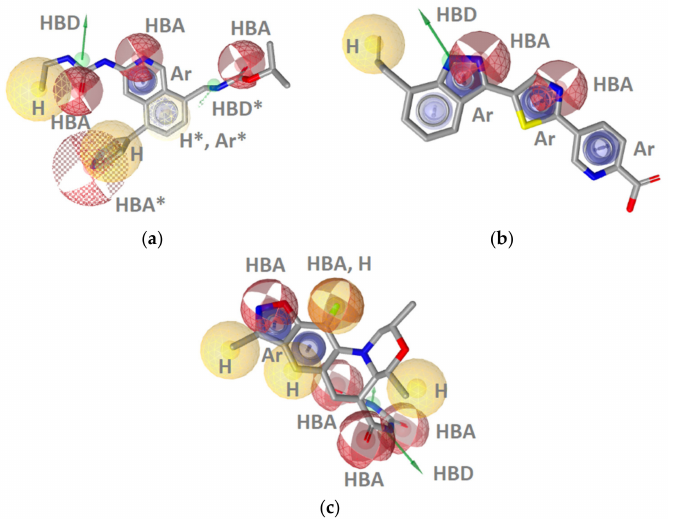
Figure 5. Three of the best performing GyrB inhibitor ligand-based models resulting from clustering a dataset of 221 very active GyrB inhibitors: ( a ) LB-GyrB-Model-5m ; ( b ) LB-GyrB-Model-4 ; ( c ) LB- GyrB-Model-6 . The pharmacophore features are as follows: hydrophobic (H, yellow spheres), aromatic (Ar, blue disc), hydrogen bond donor (HBD, green arrow), and hydrogen bond acceptor (HBA, red sphere). Optional pharmacophore features are marked with